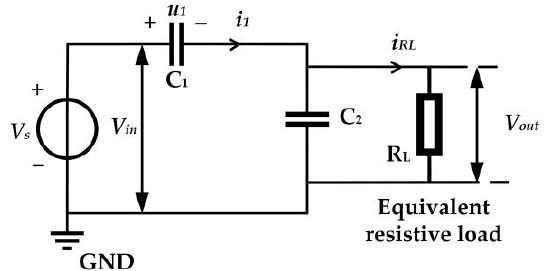
Figure 2. Schematic diagram of VFTO measurement sensor.